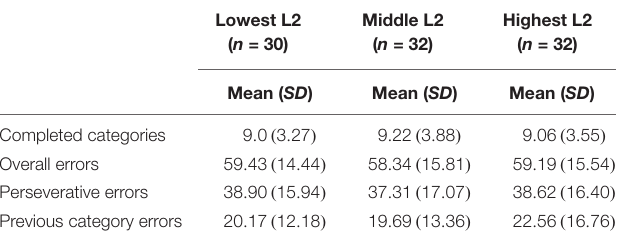
TABLE 3 | WCST performances across